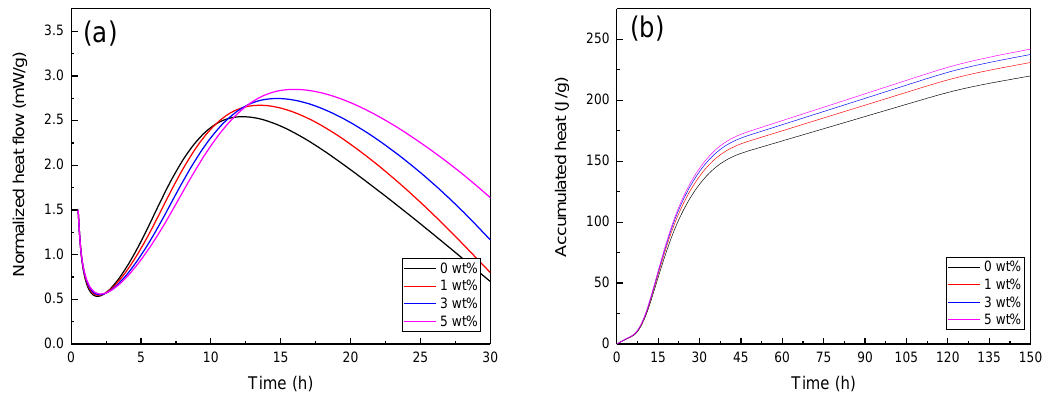
Figure 10. Hydration heat of cement paste with different nanohybrids vs. time: ( a ) instantaneous heat flow and ( b ) cumulative heat flow.